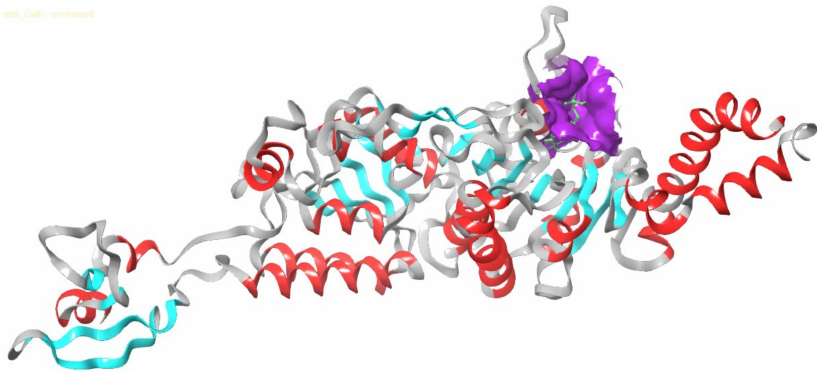
Figure 1. Three-dimensional view of modeled structure of